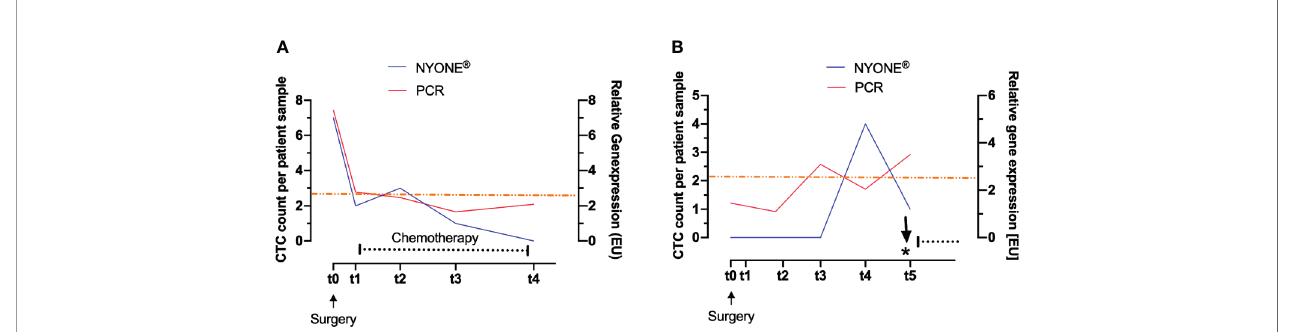
FIGURE 4 | Evaluation of CTC load during individual longitudinal patient courses. CTC were enumerated by two altering methods: cytologically after IF-staining by detection with the NYONE ® (blue line) and molecularly by analysis of CK20-gene expression by RT-qPCR (red line). The asterisk indicates the time point of diagnosis of the local recurrence of carcinoma. The black dotted line indicates the interval of chemotherapy. The orange line represents the clinically signi fi cant cut-off value of CTC detected by CK20 RT-qPCR. (A) CRC patient with stage III carcinoma of the descending colon. After the operation, the CTC load dropped markedly and under the adjuvant therapy, no signi fi cant rise in CTC was observed. (B) CRC patient with stage II carcinoma of the descending colon. A total of 24 weeks after the operation, a clear rise of CTC in both detection methods was monitored, with the PCR-based approach being even earlier Clinically no signi fi cant follow-up event was recorded. Thirteen months after t0 a local recurrence of the carcinoma was